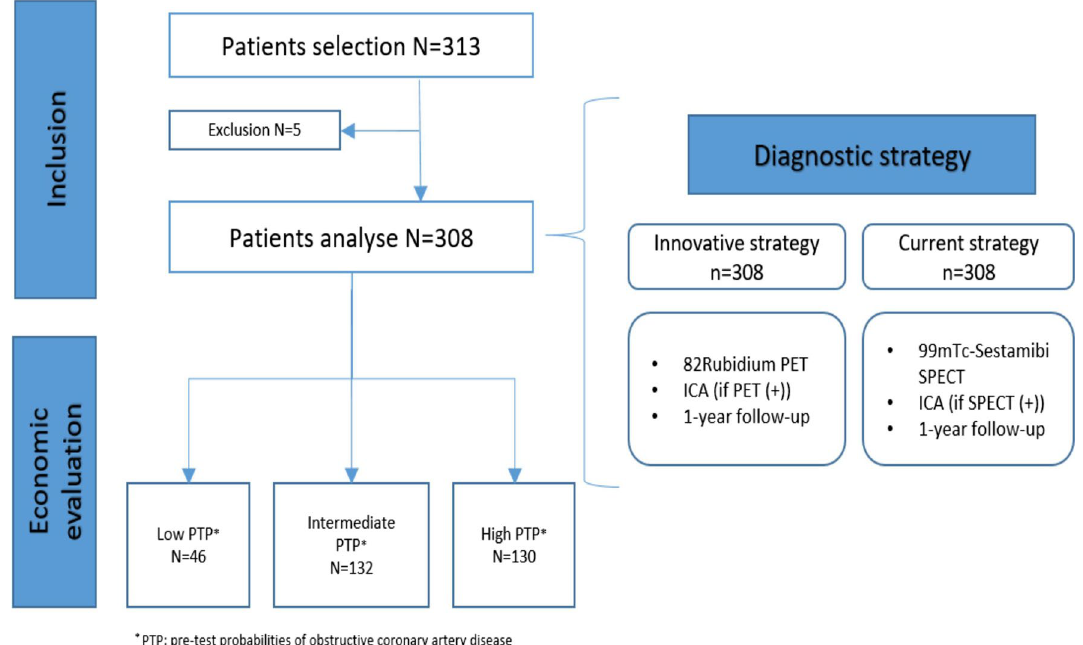
Fig. 1 Flowchart of the economic